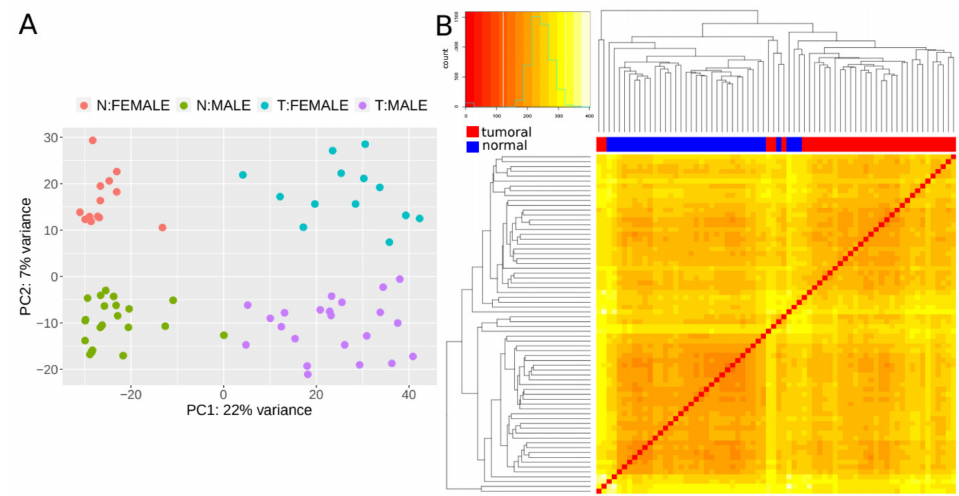
Figure 3. Expression patterns of lncRNAs. ( A ) Principal component analysis (PCA) plot based on transformed count data after variance stabilizing transformation. T and N indicate tumoral and normal samples, respectively. ( B ) Heatmap showing the overall similarity between samples based on a hierarchical clustering of the Euclidean distance between samples using the variance stabilizing transformation (vst-transformed) data. Red and blue bars at the top of the columns designate tumoral and normal samples,